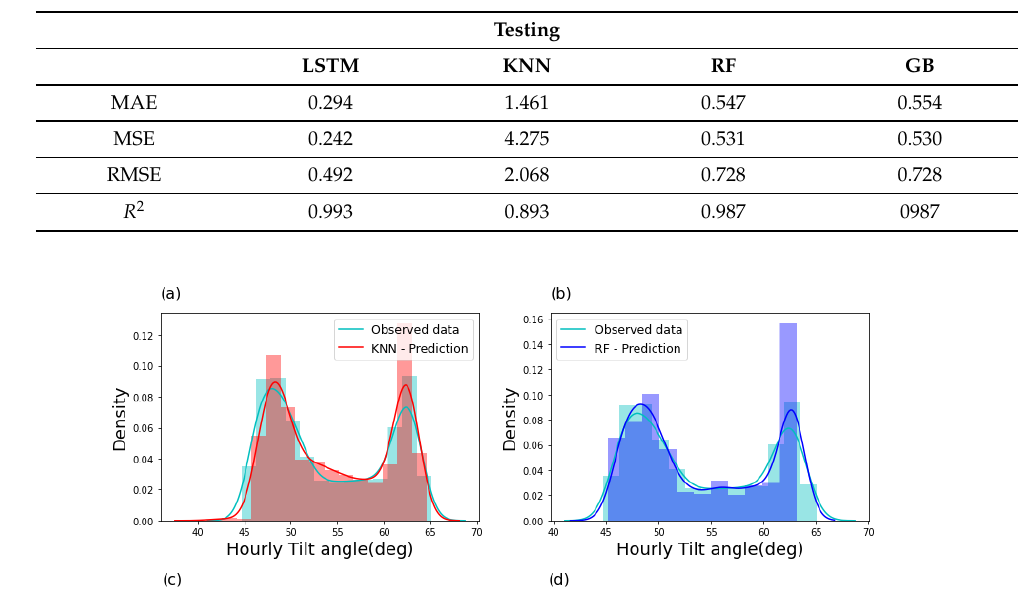
Table 5. Testing errors of the RF, KNN, LSTM and GB models for predicting tilt angle of acceptance for solar energy, with error measured in degree unit of the target variable.